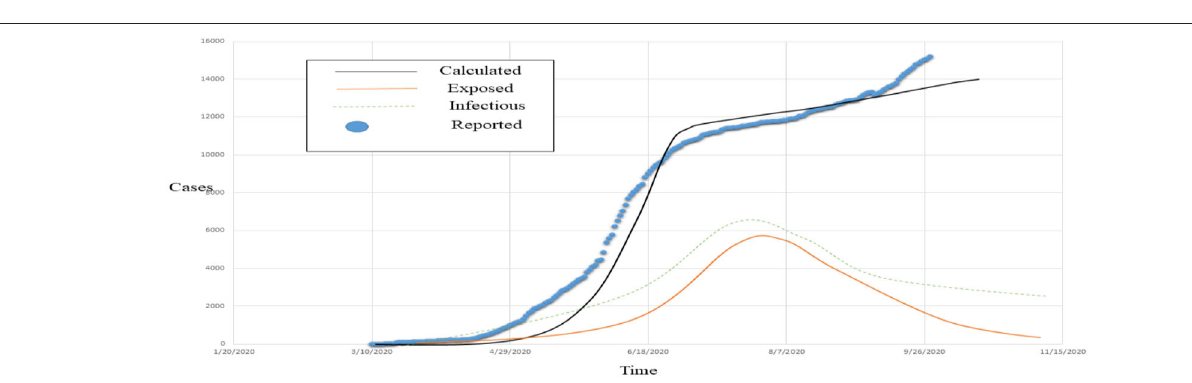
different models, the advantages can still be quite subtle and